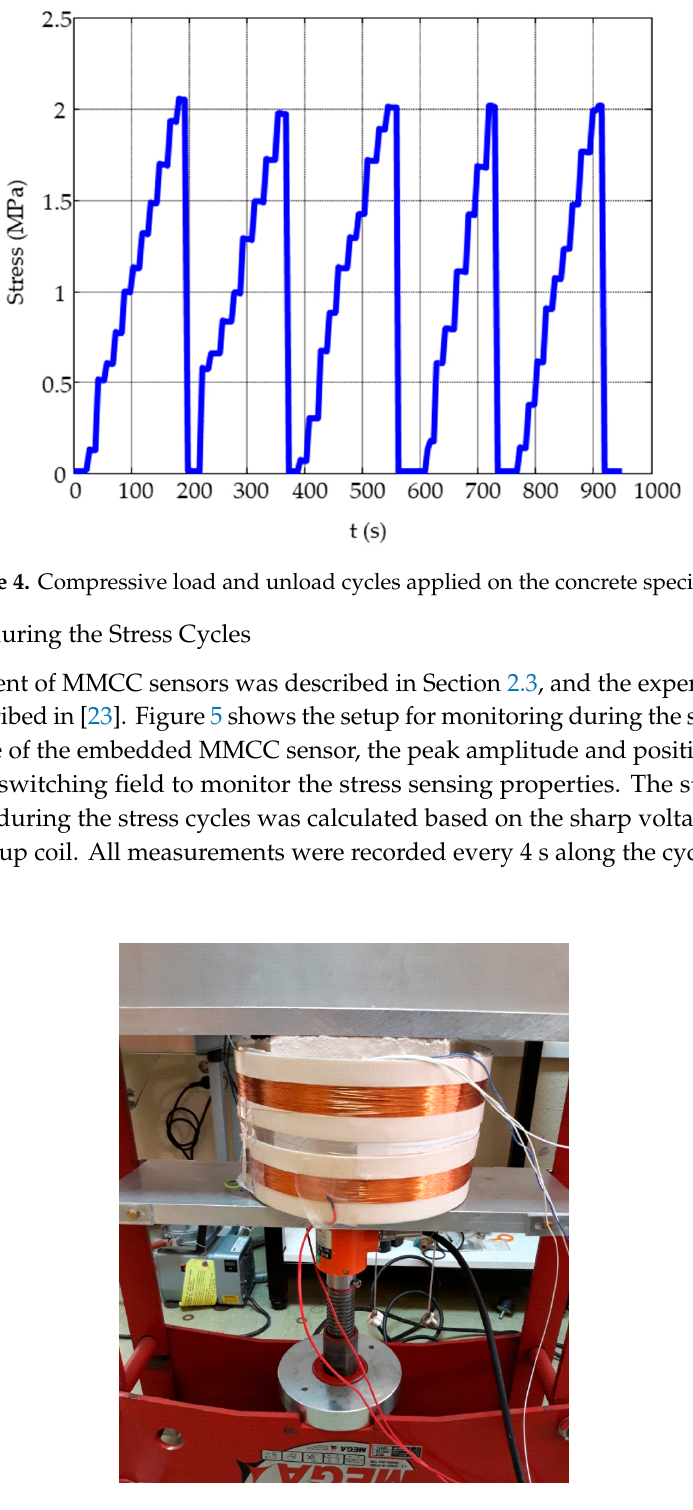
Figure 5. Concrete specimen with MMCC sensors and strain gauge placed in the hydraulic press.